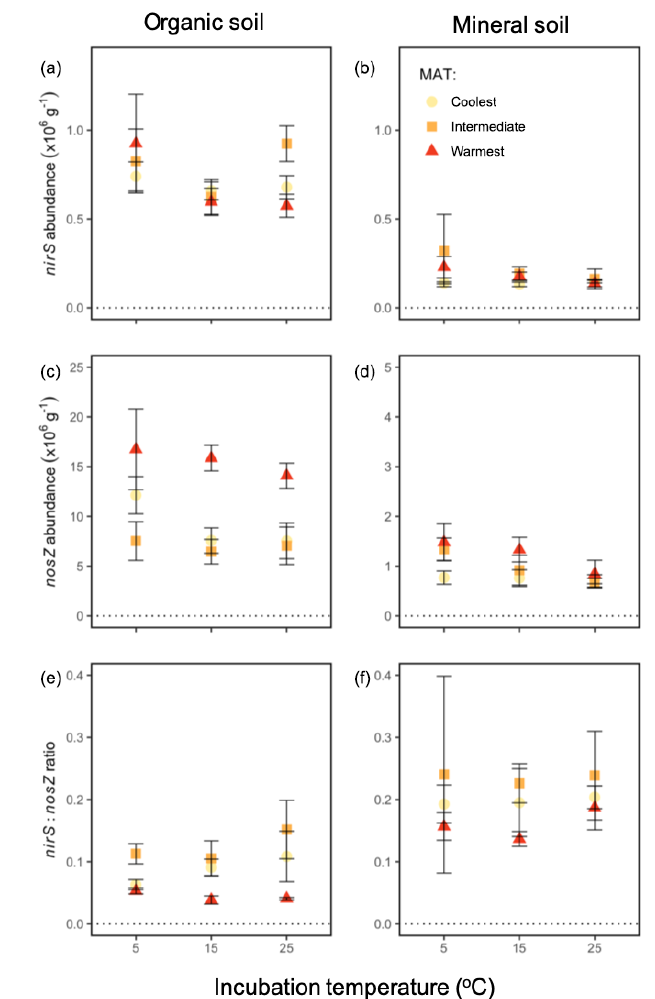
Figure 6. Functional gene abundances during a 60h incubation at 5, 15, and 25 ◦ C from soil from three boreal forest regions along a latitudinal transect: nirS in the organic (a) and mineral (b) soil; nosZ in the organic (c) and mineral (d) soil; and the ratio of nirS : nosZ in the organic (e) and mineral (f) soil. Note that the y axis scales differ for each row and between panels (c) and (d) . “MAT” refers to the mean annual temperature. The “coolest” region is the Eagle River watershed (northern boreal), the “intermediate” region is the Salmon River watershed (mid-boreal), and the “warmest” region is the Grand Codroy watershed (southern boreal). See the text site de- scriptions. Values are provided as the mean ± 1SE ( n = 3 forests per latitudinal